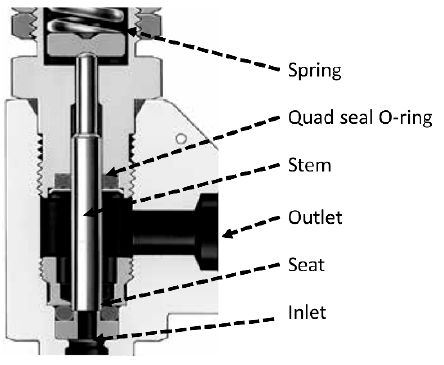
Figure 2. Relief valve used for manual adjustment of